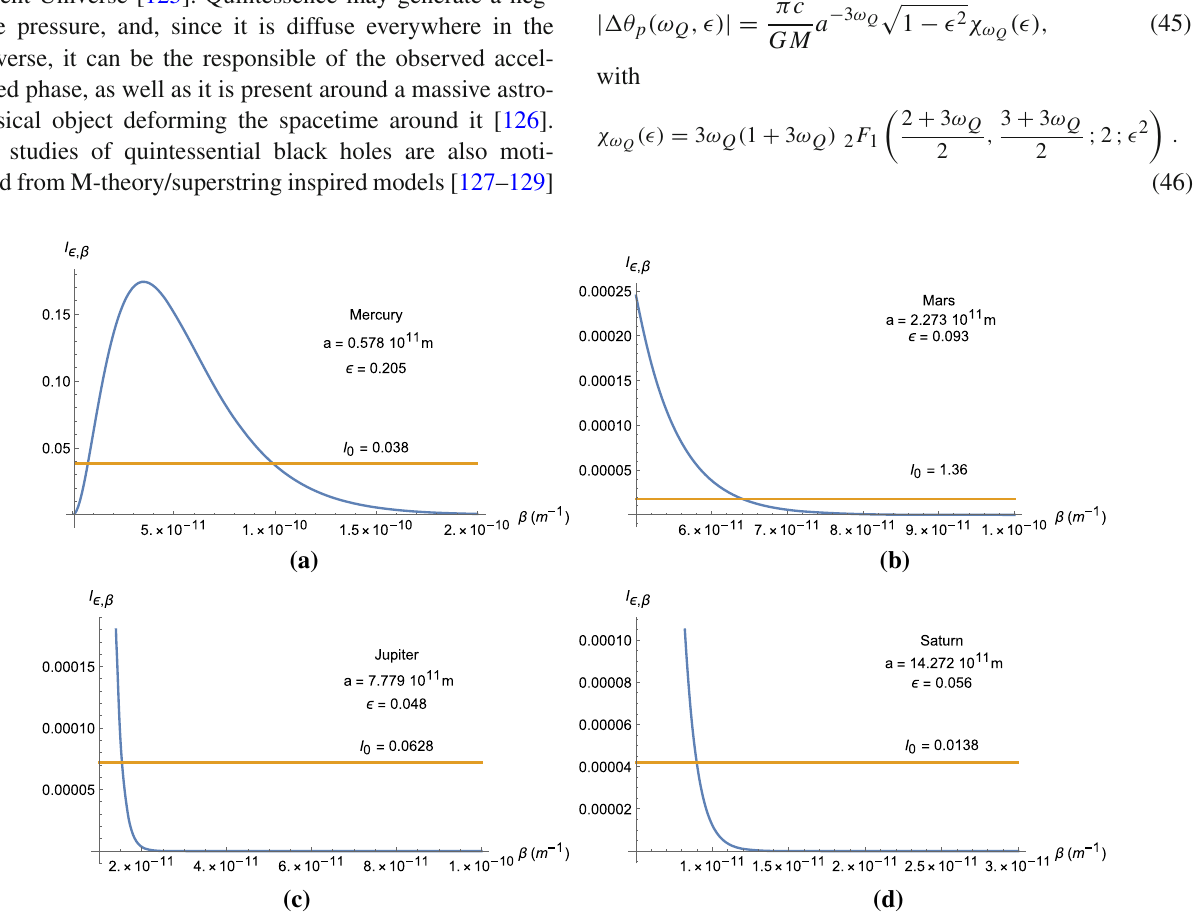
Fig. 3 a I (cid:10),β vs β for Mercury. b I (cid:10),β vs β for Mars. c I (cid:10),β vs β for Jupiter. d I (cid:10),β vs β for